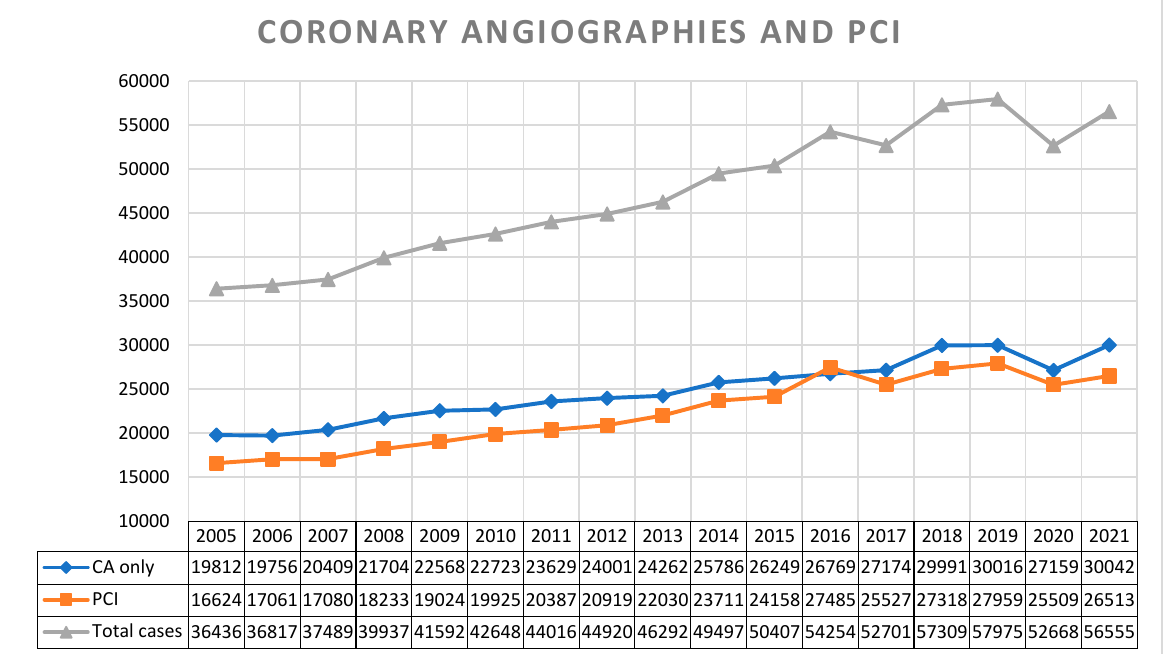
Figure 1. Trends in coronary angiographies and percutaneous coronary interventions in Switzerland from 2005 to 2021. (CA only—coronary angiographies only, without intervention. PCI—percutaneous coronary intervention, including preceding diagnostic angiography).